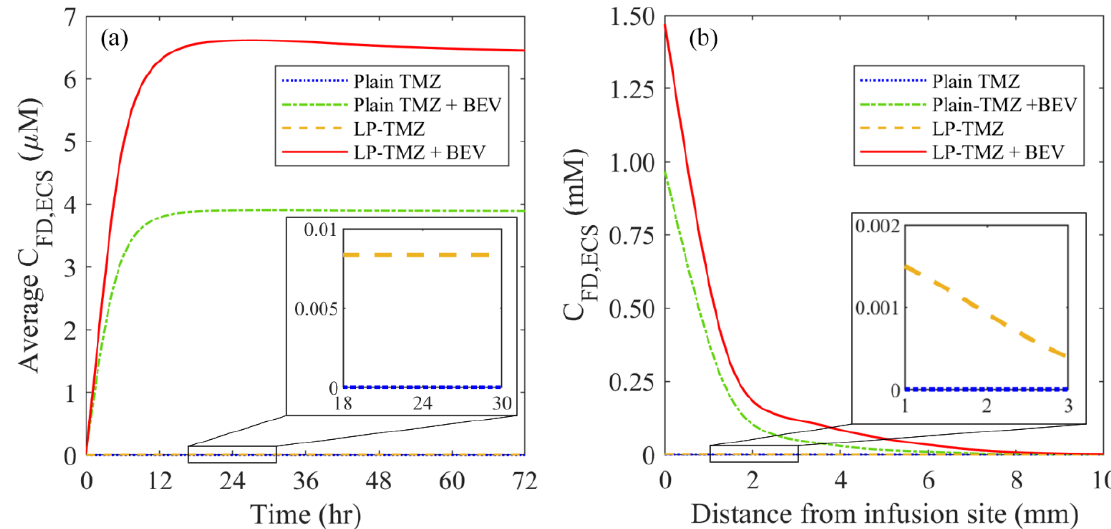
Figure 11. Spatial distribution of released free temozolomide at different time points.